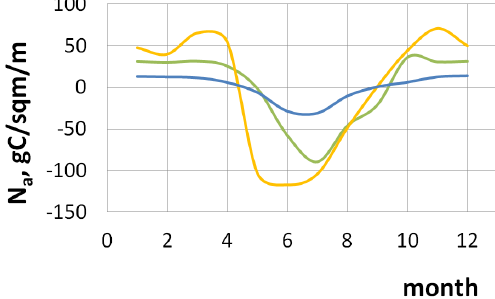
Figure 6. The seasonal cycle of the local N a,mod for WUE = 2.7gCL − 1 , Q 10 = 1.4, and φ = 0.2 (green) as compared that for WUE = 1.8gCL − 1 , Q 10 =2.0, and φ = 0 (blue) and to the detrended NEE observed at the “Hesse Forest” site of Fluxnet